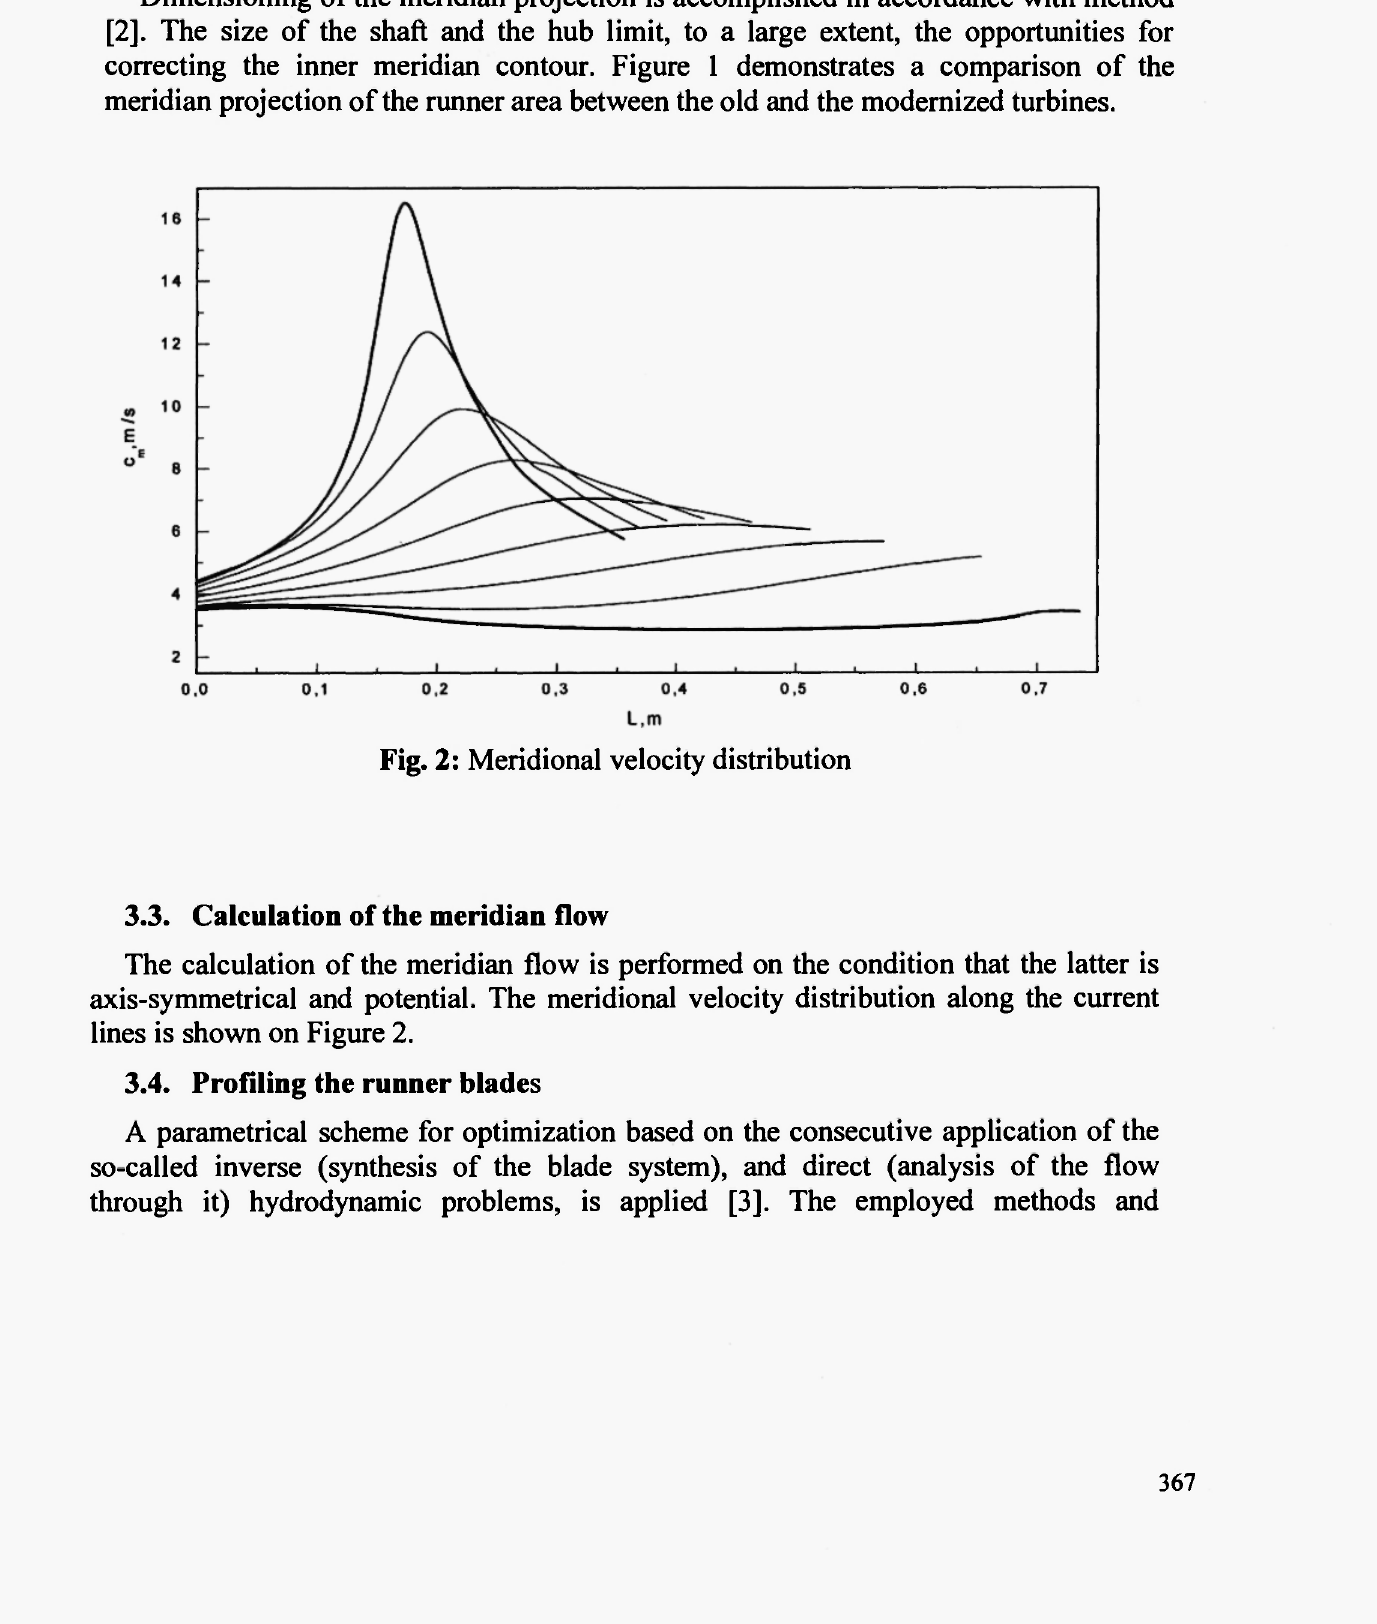
Fig. 2: Meridional velocity